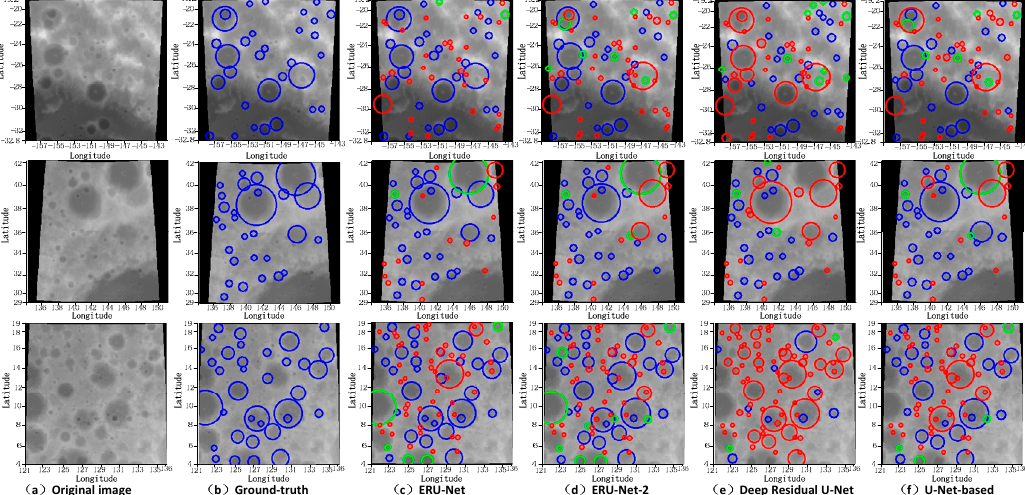
Figure 4. Crater recognition results of different networks. ( a ) The original lunar DEM (digital elevation model) data. ( b ) Ground-truth images. Blue circles denote ground-truth craters. ( c ) The recognition results of our proposed ERU-Net. ( d ) The recognition results of ERU-Net with two Res-Blocks. ( e ) The recognition results of deep residual U-Net [29]. ( f ) The recognition results of the network designed by [36]. In ( c – f ), red circles denote unrecognized craters, blue circles denote correctly recognized craters, and green circles denote new craters predicted by the network.